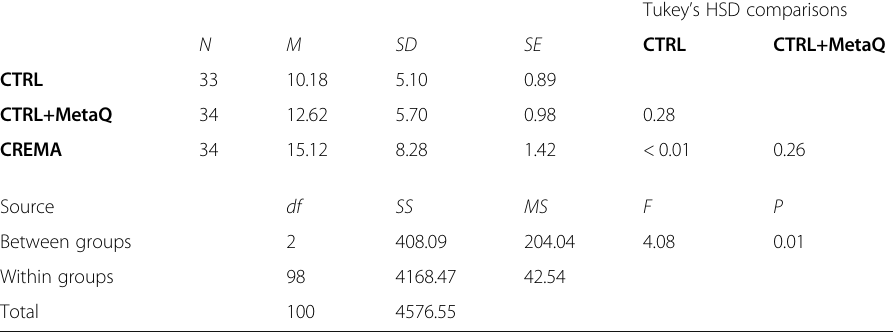
Table 8 ANOVA results and descriptive statistics for MWP